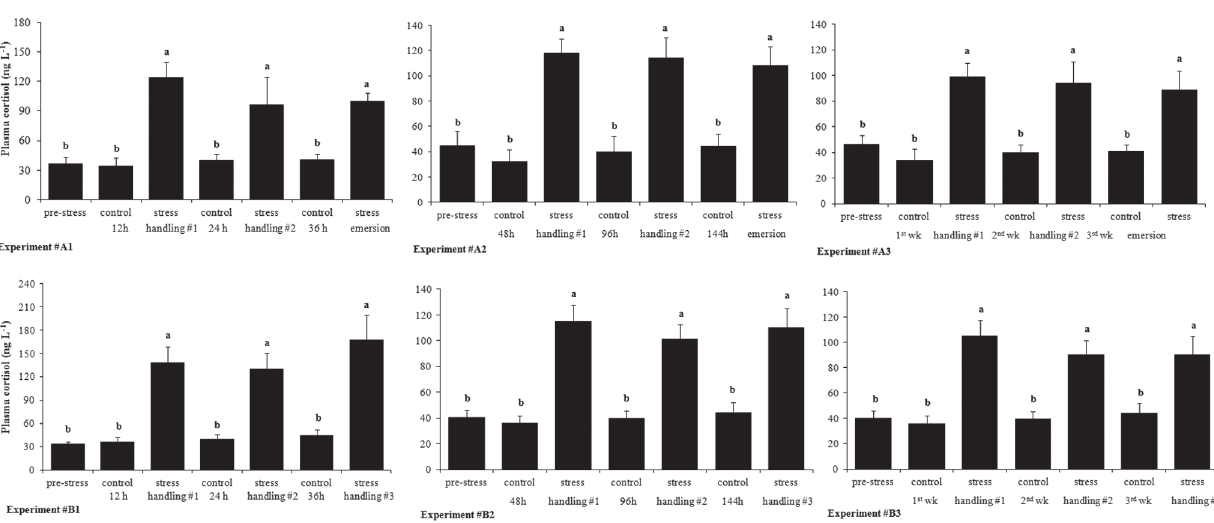
Fig. 2. Plasma cortisol concentrations of R . quelen (Quoy & Gaimard) fingerlings exposed to sequential acute stressors. Comparison of responses to two similar stressors and a third different stressor in experiment “A” and comparison of responses to three sequential stressors of the same type in experiment “B.” Data are expressed in terms of mean ± S.E.M. values. The different small letters above the histograms indicate statistical differences by ANOVA, followed by Tukey’s range test. (n =